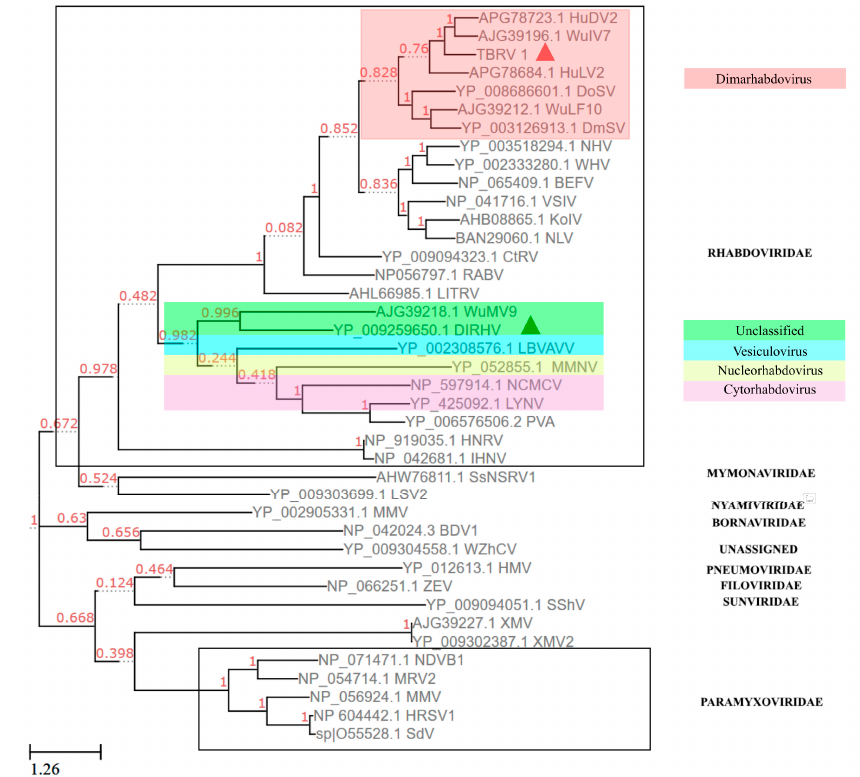
Figure 3. Maximum likelihood phylogenetic tree of TbRV-1 based on the RdRP protein and alignment. The numbers near the branches represent the percentage of the 1000 bootstrap iterations supporting the branches. The phylogeny was drawn with ETE Toolkit v3 software. The virus TbRV-1 and DlRhV were respectively marked with red and green triangles.